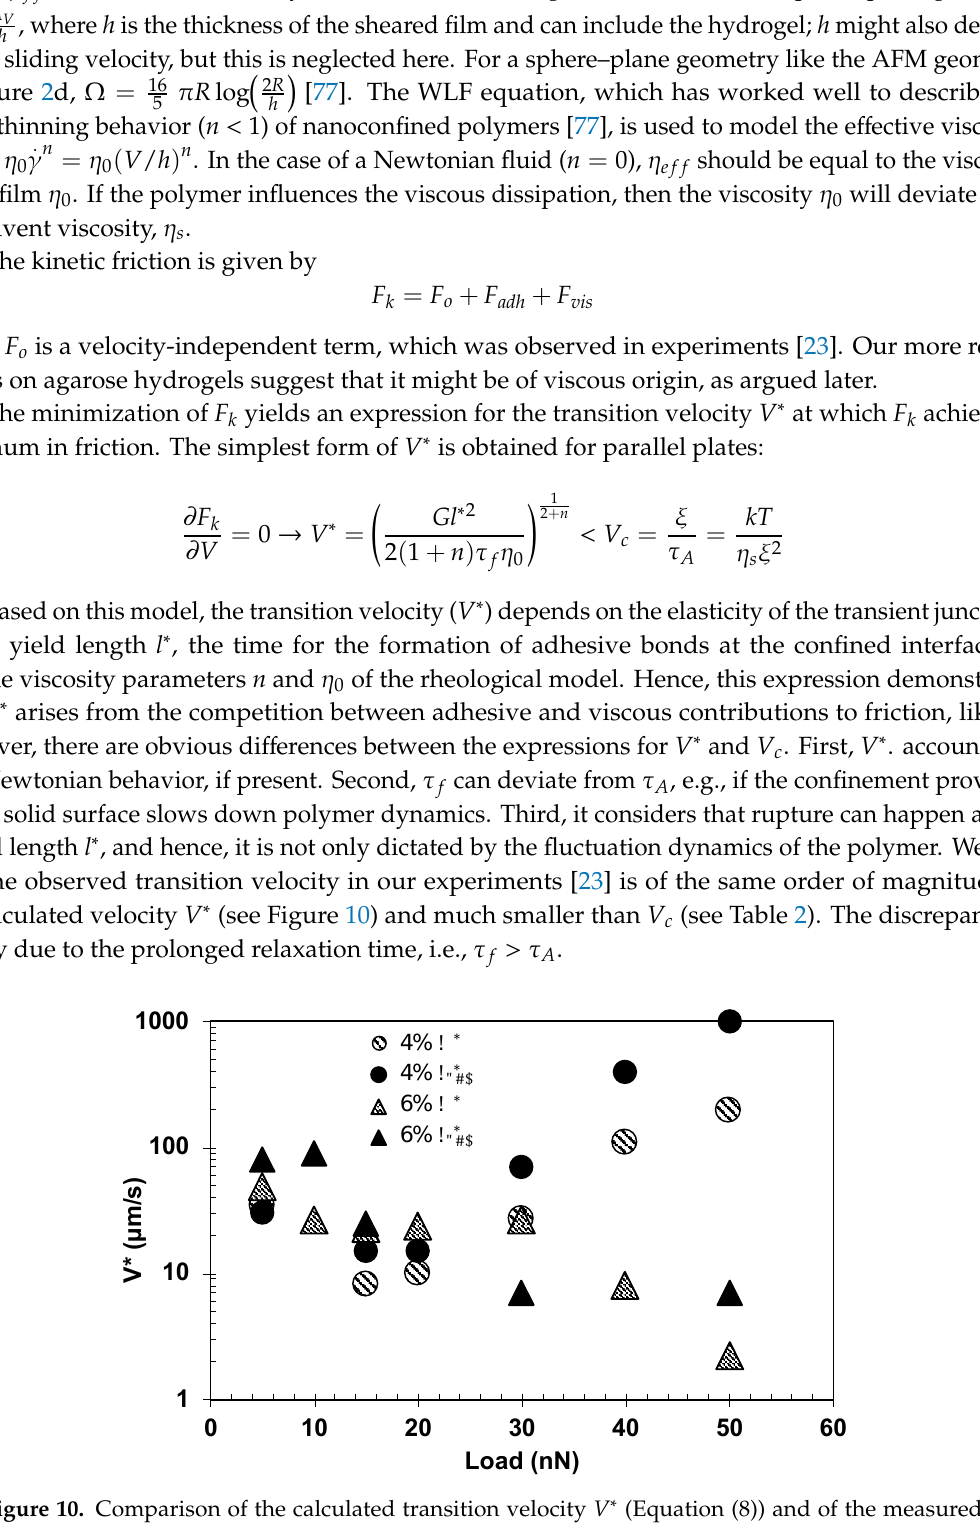
Figure 10. Comparison of the calculated transition velocity V ∗ (Equation (8)) and of the measured transition velocity V ∗ exp in AFM friction-force experiments on polyacrylamide hydrogels with 4 and 6 wt % acrylamide. Data used with permission from Ref. [23].